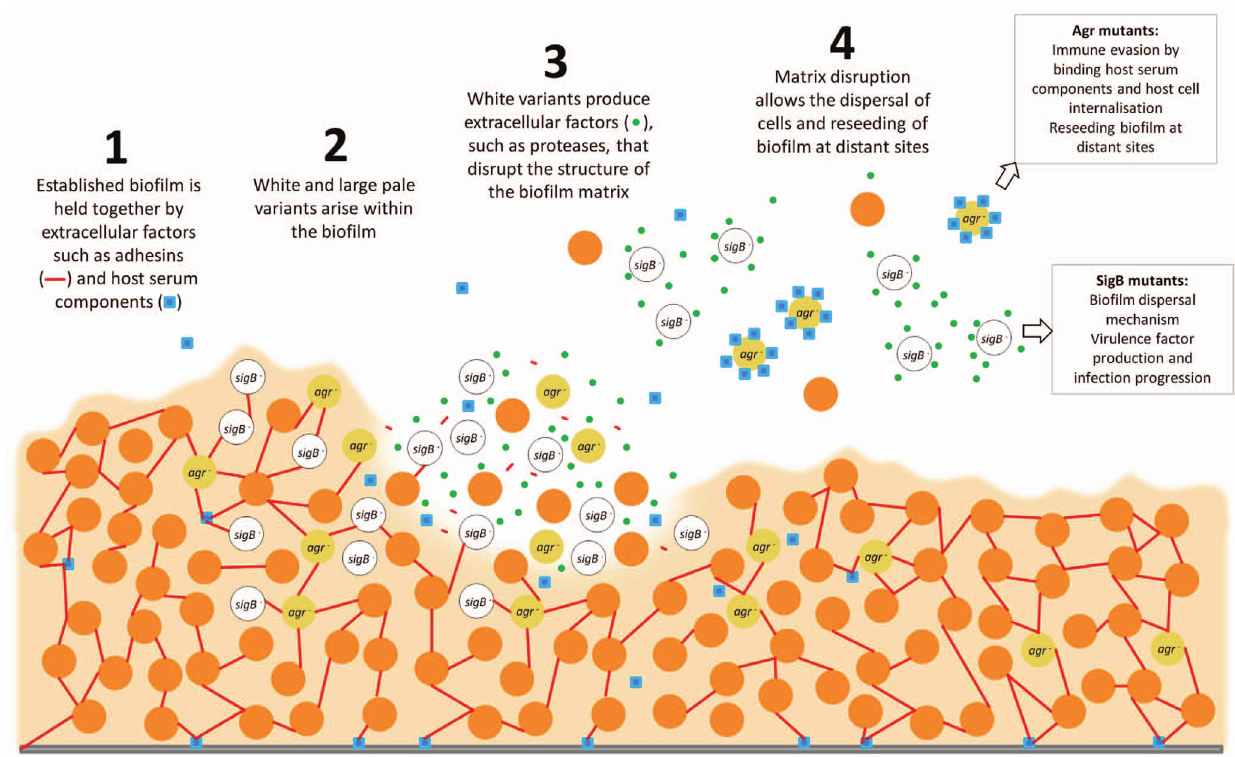
Figure 4. Schematic representation of the emergence and role of morphological variants in S.aureus biofilms during infection.